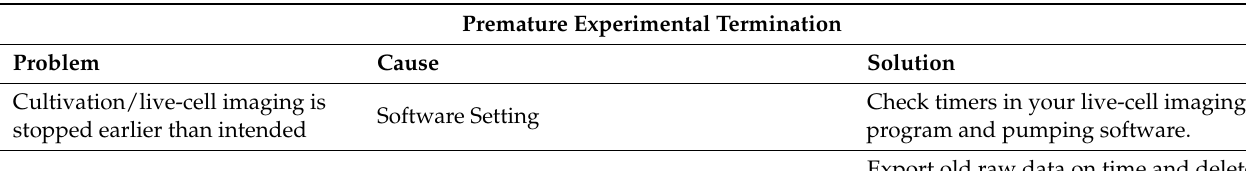
Table 12. Listed are the most frequently occurring challenges concerning premature experimental termination with their respective cause and a suggested